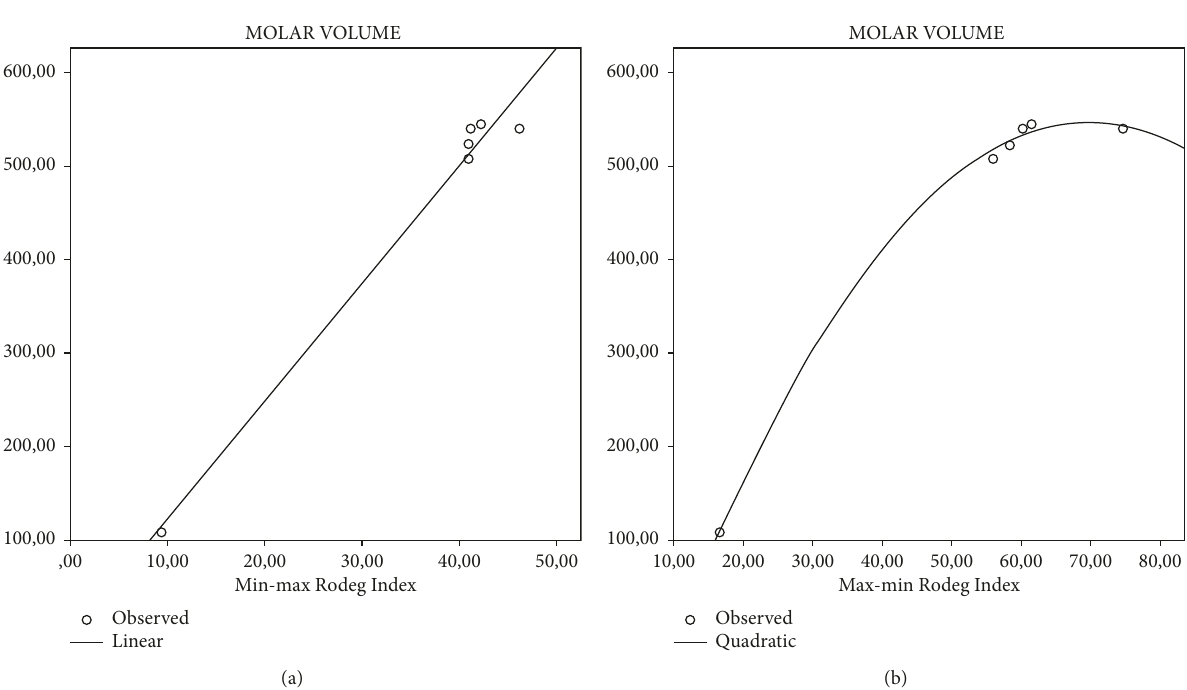
Figure 3: The plots of the linear and quadratic regression equations of the molar volume with the min-max rodeg index and the max-min rodeg index,